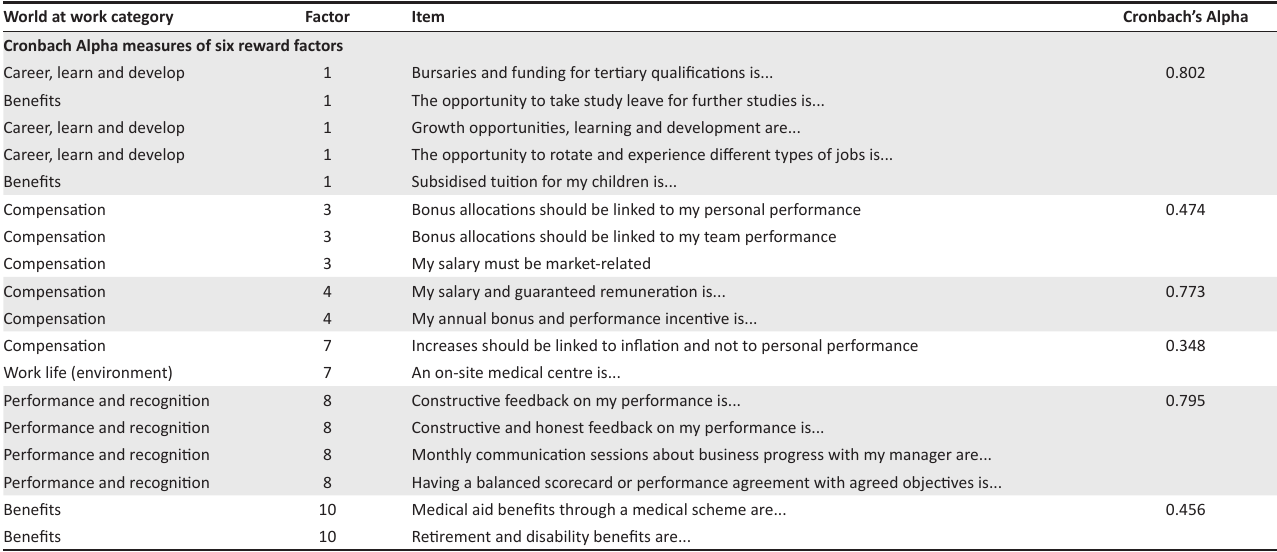
TABLE 6: Reliability reward measures for research hypothesis. World at work category Factor